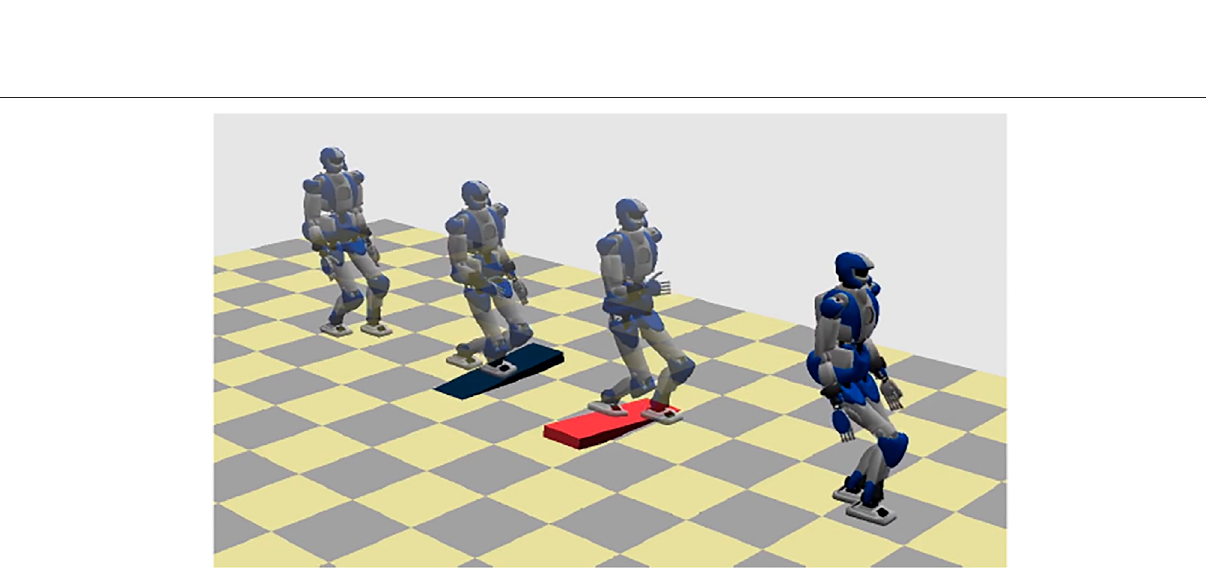
FIGURE 16 | Running over tilted surfaces: stroboscopic motion.